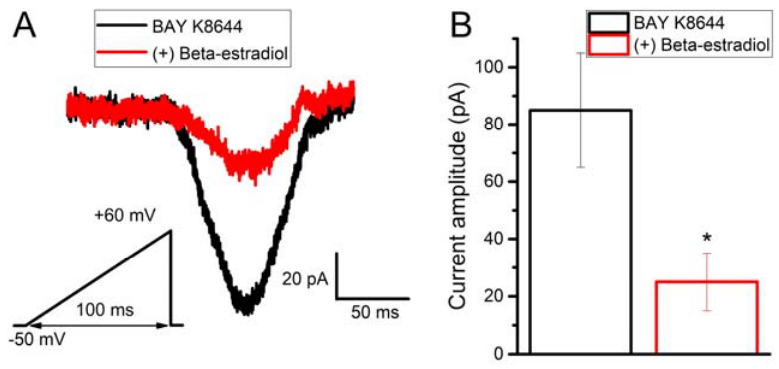
Figure 6. Beta-estradiol partly blocks voltage-gated calcium currents in TCs from pregnant uterine myometrium. ( A ) Representative patch-clamp recording in voltage-clamp mode on a human myometrial TC. Brief depolarizing ramp protocols from − 50 to +60 mV with a duration of 100 ms were applied. HVA currents were elicited by perfusion with Bay K8644 (2.5 µ M) for 1 min followed by